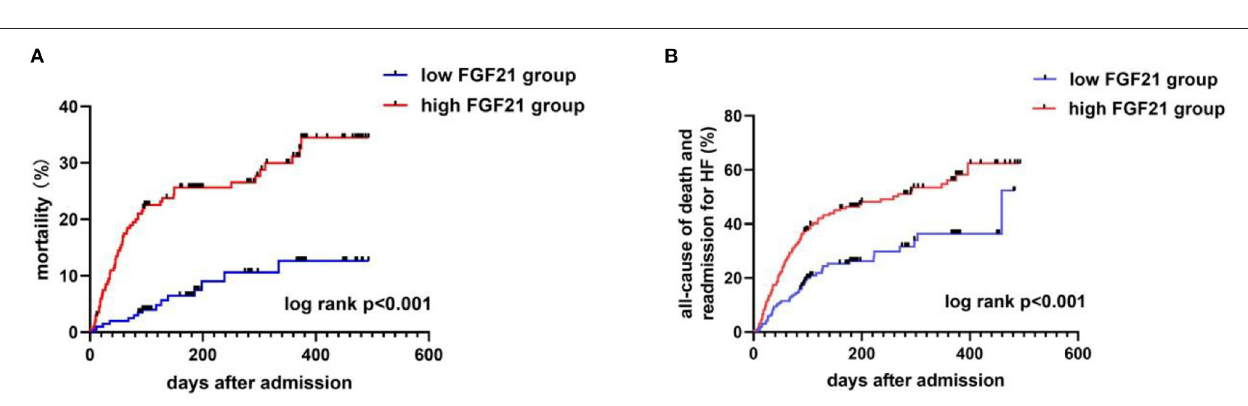
FIGURE 4 | Kaplan-Meier curves for all-cause death (A) and composite endpoints (B) stratified by FGF21 median in AHF patients. Mortality (A) and composite endpoints (B) were significantly higher in the high FGF21 group than the low FGF21 group ( p < 0.001).